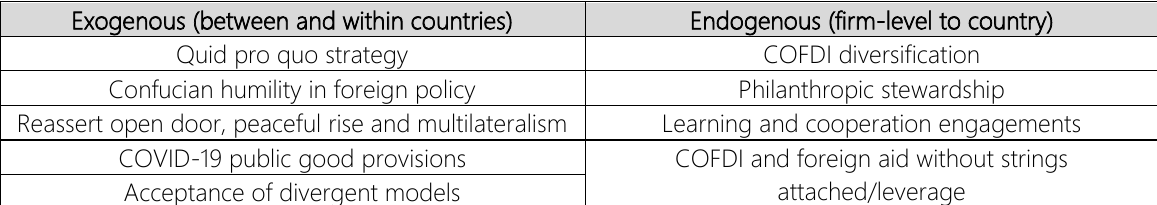
Table 3: Exogenous and endogenous strategies for optimizing COFDI soft power (Source: Author‘s own